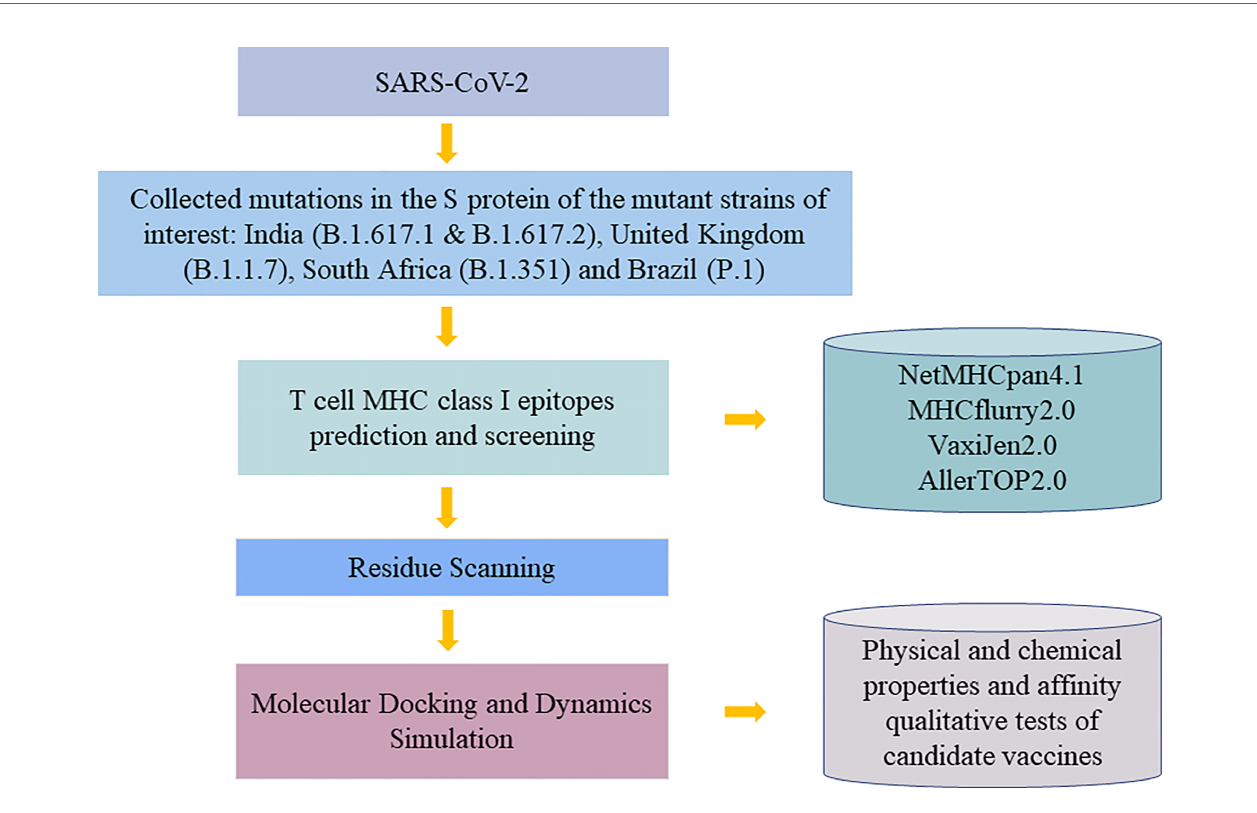
FIGURE 1 | Flowchart in the vaccine design